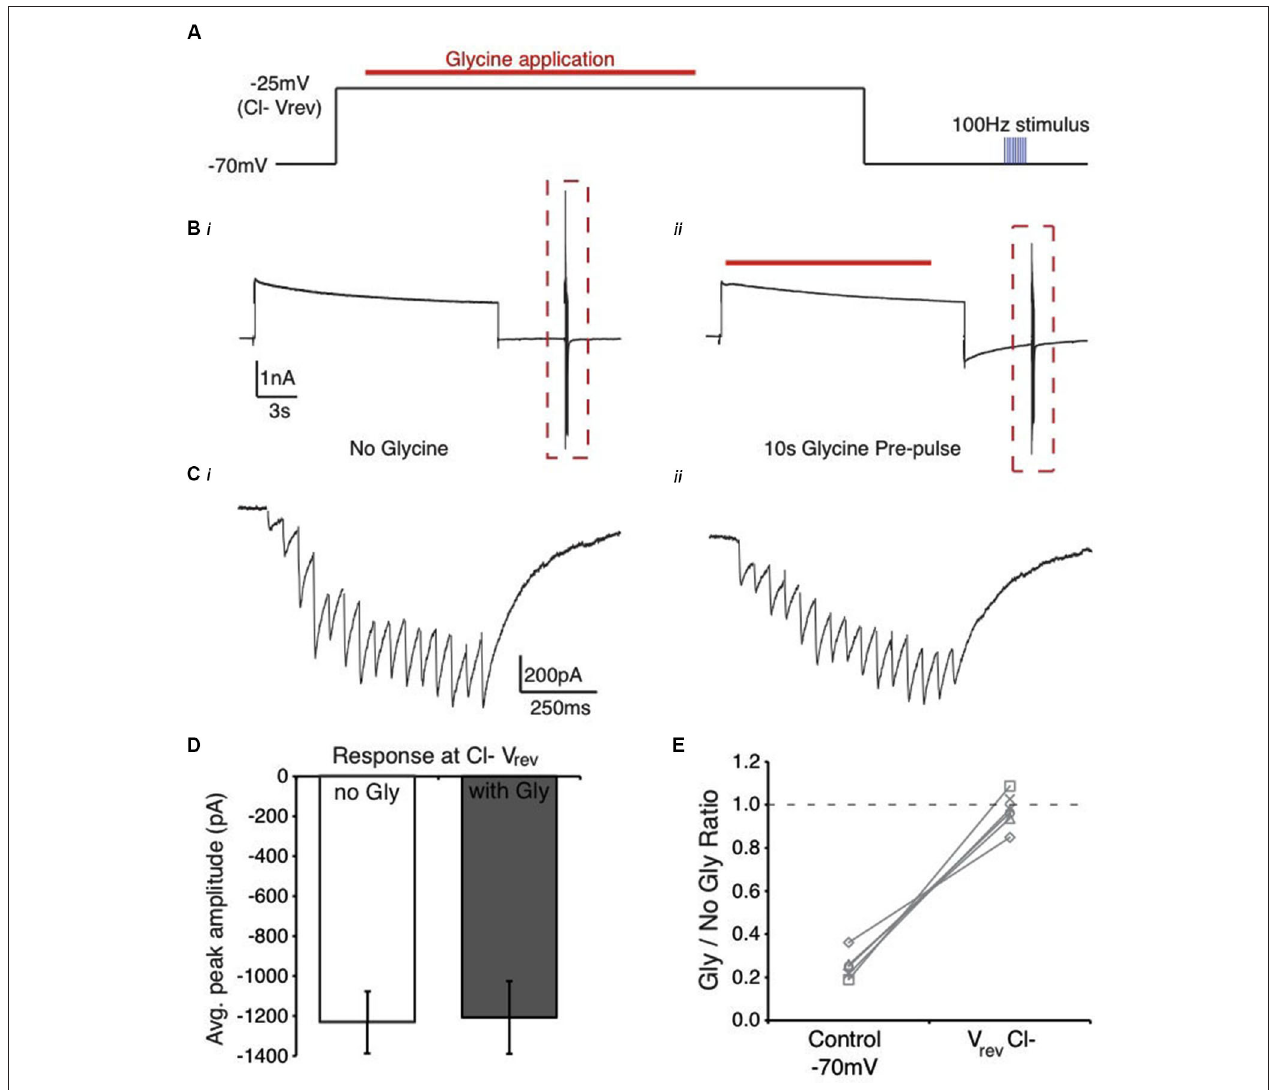
FIGURE 5 | Manipulation of Cl − ion flux alters the suppression profile of glycine pre-application in the NM. (A) Schematic of voltage clamp protocol where Cl − flux is minimized by holding the membrane at the reversal potential for Cl − during the glycine application. (B) Current response from protocol in (A) in the absence (Bi) and presence (Bii) glycine pre-application (red line). Note the similarity between the traces in (Bi) and (Bii) , suggesting minimal current due to glycine application.